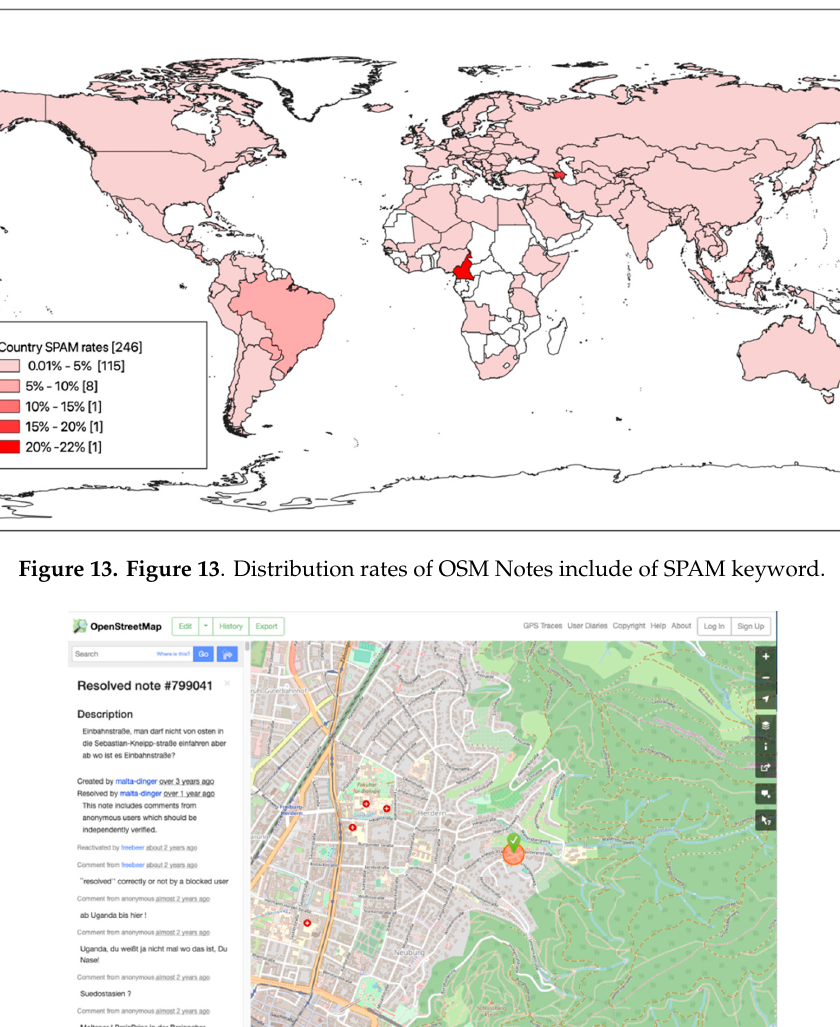
Figure 14. The most revisions of an OSM Notes case in Germany.